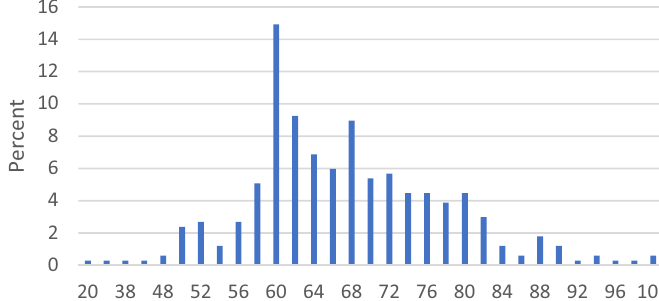
Figure 1. P2P lending awareness